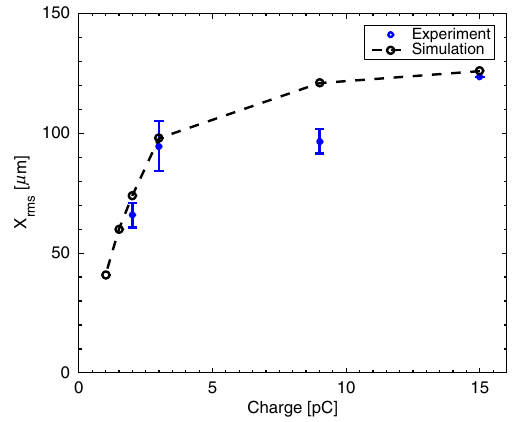
FIG. 10. Measured rms transverse spot size for different charges Q , compared with simulation from GPT.